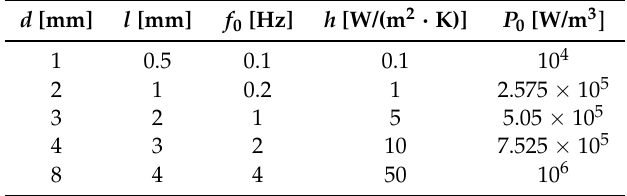
Table 2. The cuvette diameter d (Figure 1), the sample holder thickness l (Figure 1), the stimulation frequency f 0 , the convection loss h and the peak power density P 0 , proportional to the heating slope β , have been varied in this parametric study. d [mm] l